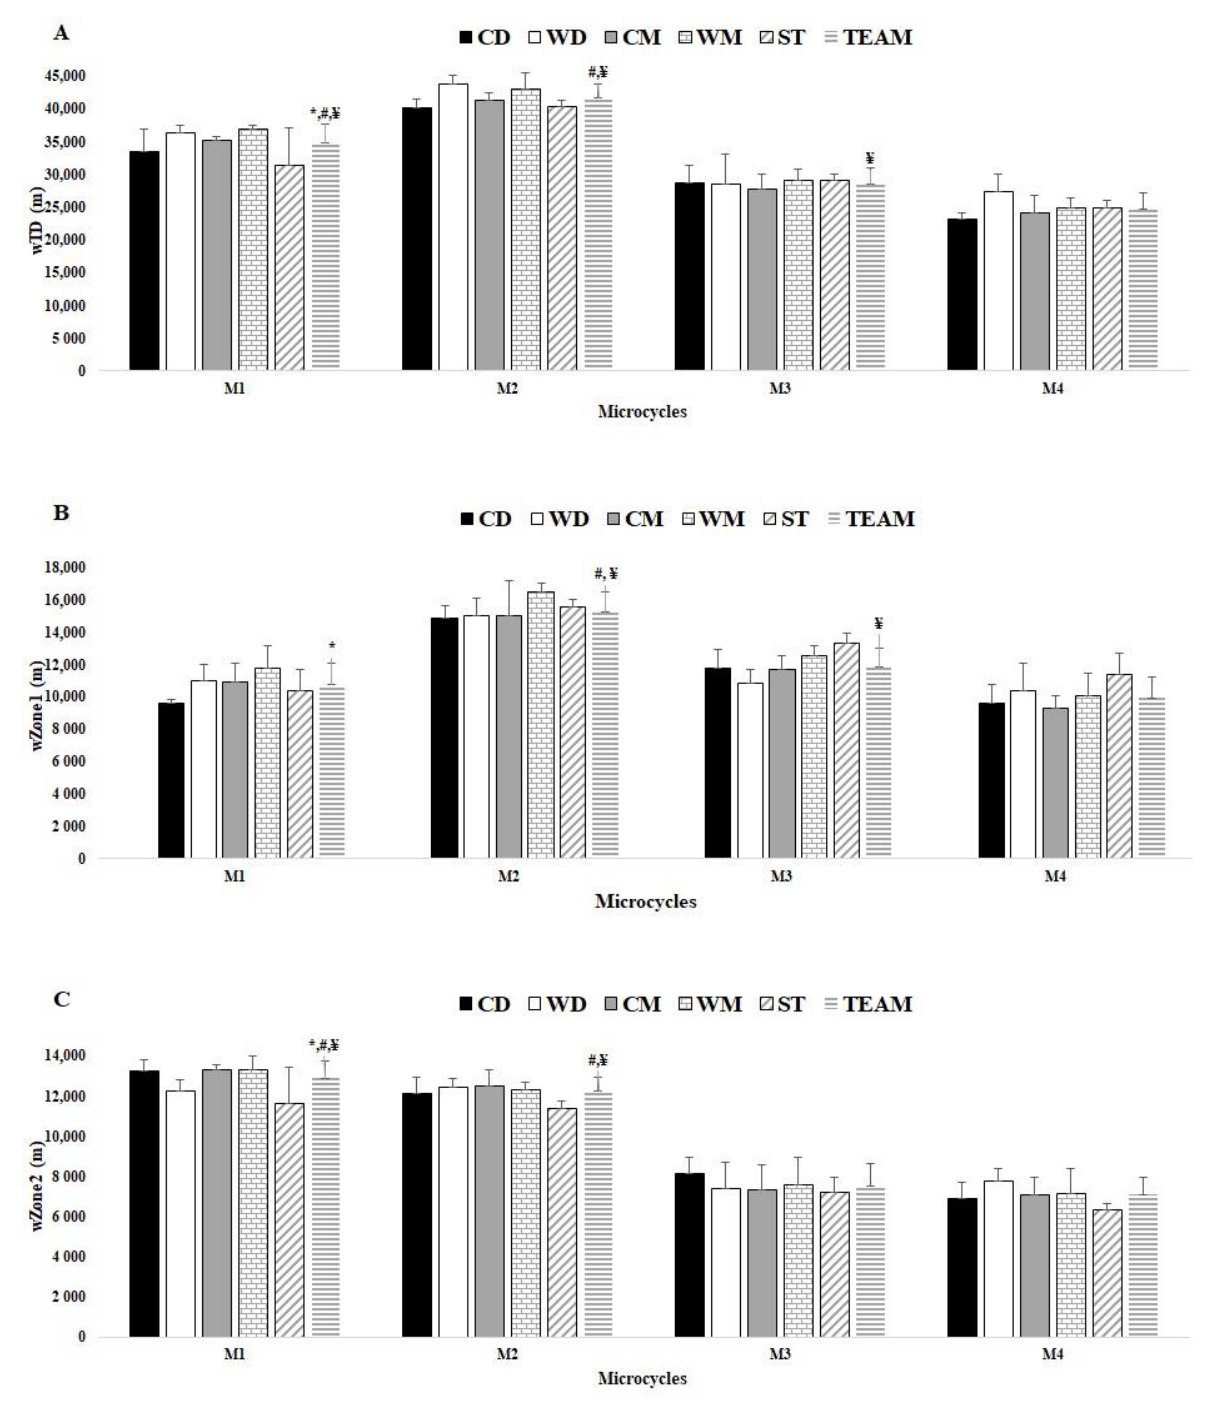
Figure 1. Comparisons between player positions for weekly total distance (wTD), Zone 1 (wZone1), and Zone 2 (wZone2) for each microcycle, (e.g., M1, M2, M3, and M4) and between Ms by team average. ( A ) wTD; ( B ) wZone1; ( C ) wZone2; * Denotes difference from M2; # denotes difference from M3; ¥ denotes difference from M4; all p < 0.05.